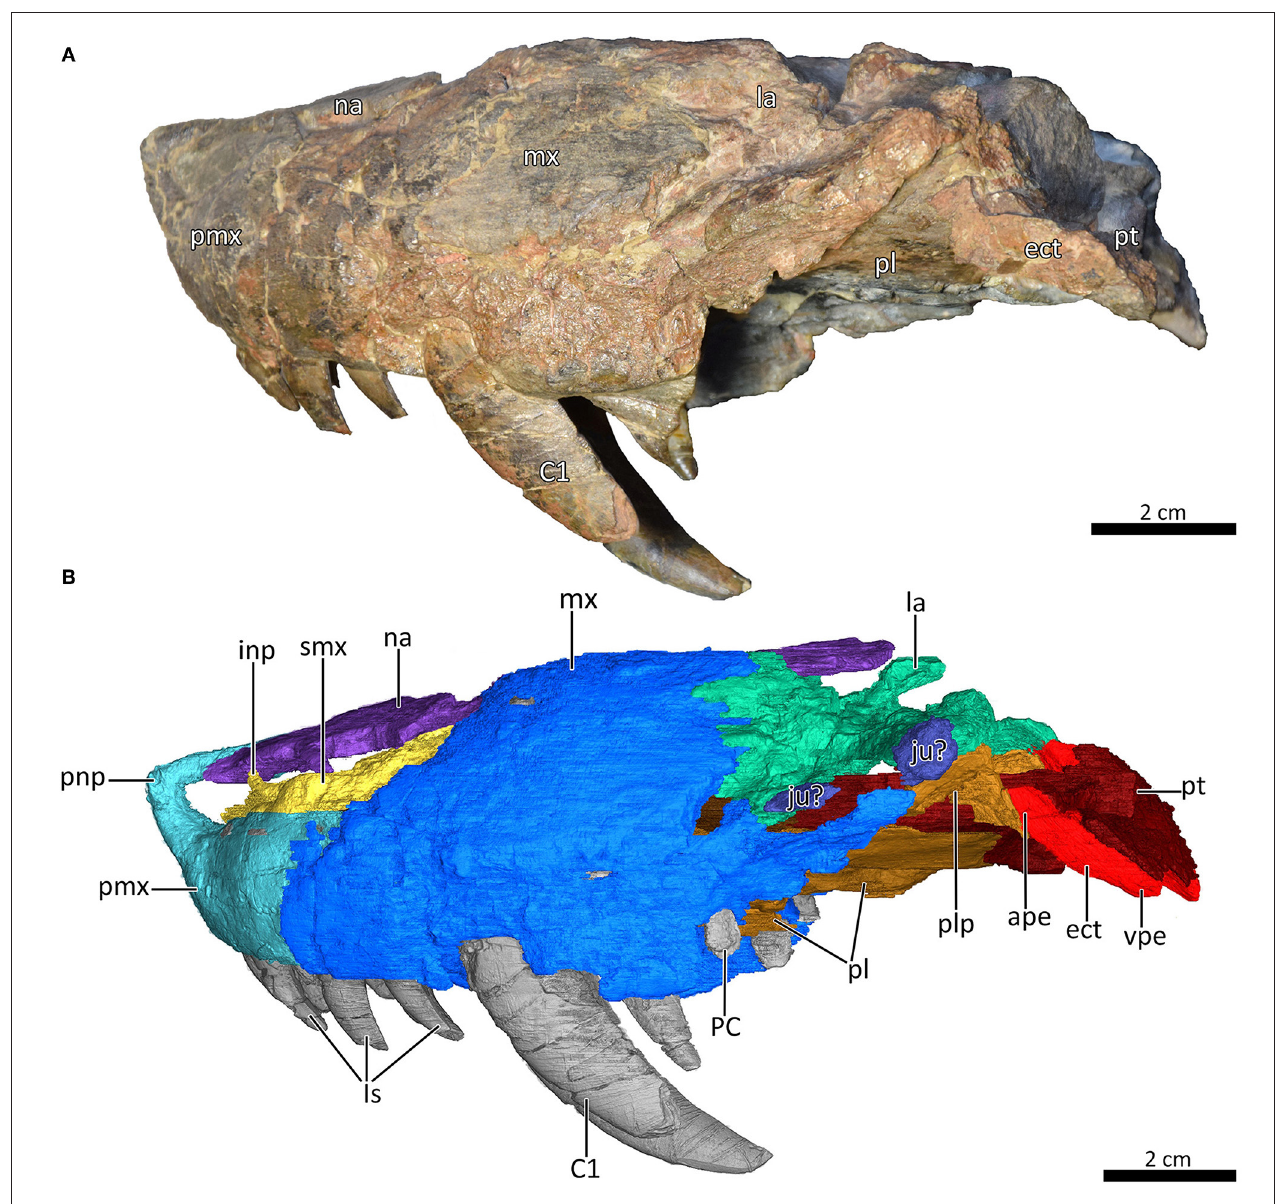
FIGURE 3 | Snout of MB.R.995 in left lateral view. (A) Photograph and (B) 3D reconstruction of the snout. ape, anterior process of the ectopterygoid; C1, first canine; ect, ectopterygoid; inp, intranarial process; Is, upper incisors; ju?, jugal?; la, lacrimal; mx, maxilla; na, nasal; PC, upper postcanine; pl, palatine; plp, posterolateral process of the palatine; pmx, premaxilla; pnp, prenasal process of the premaxilla; pt, pterygoid; smx, septomaxilla; vpe, ventral process of the